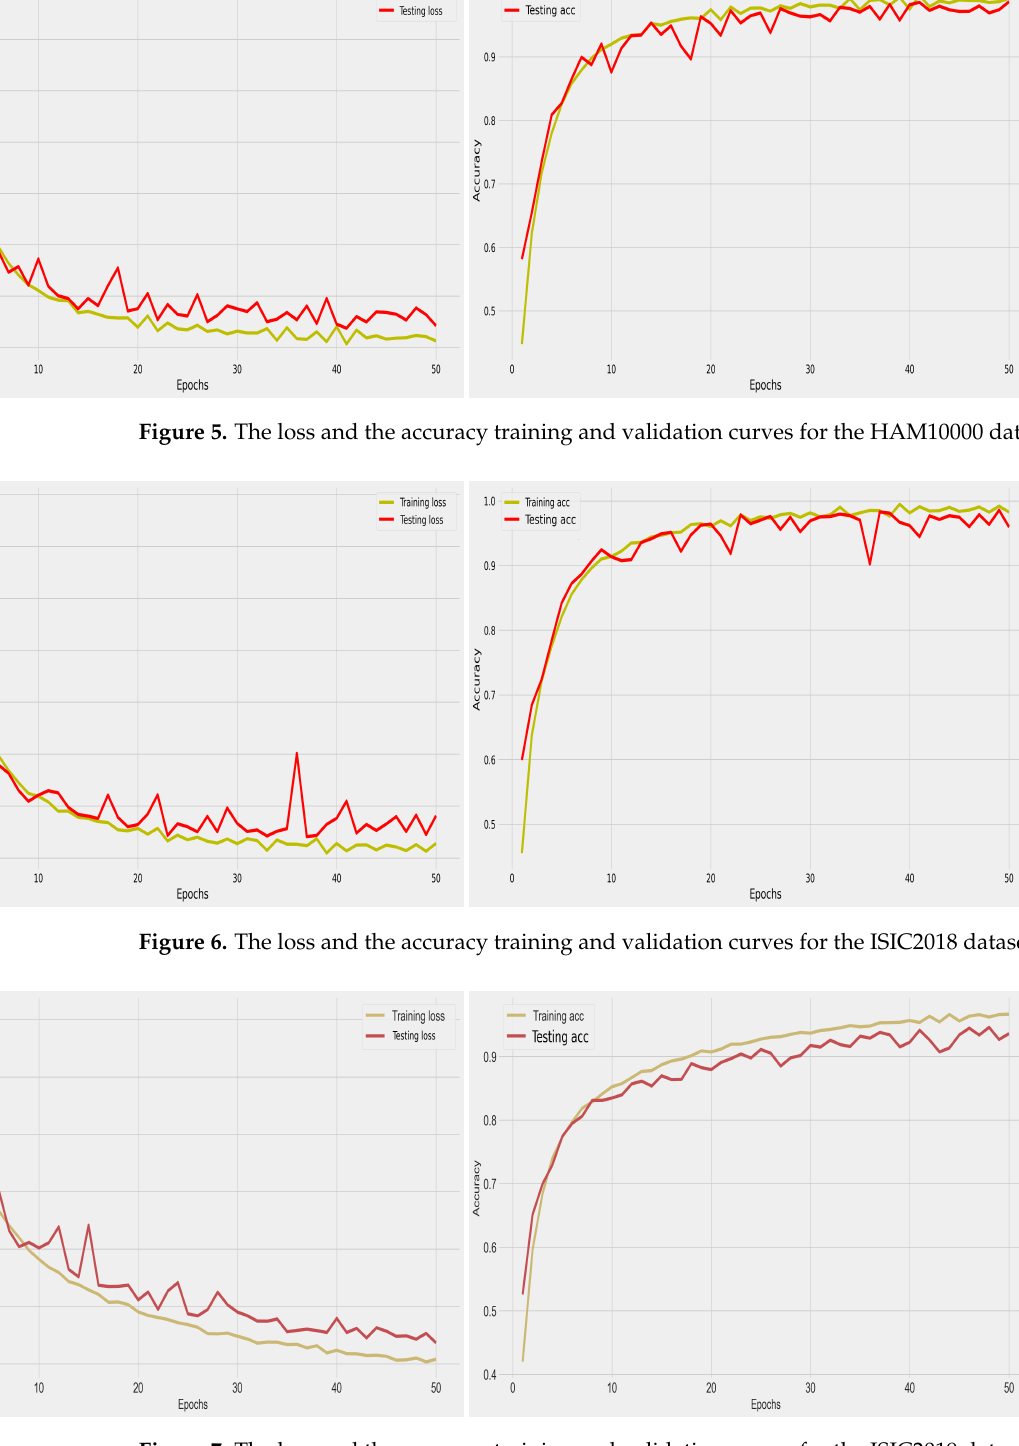
Figure 7. The loss and the accuracy training and validation curves for the ISIC2019